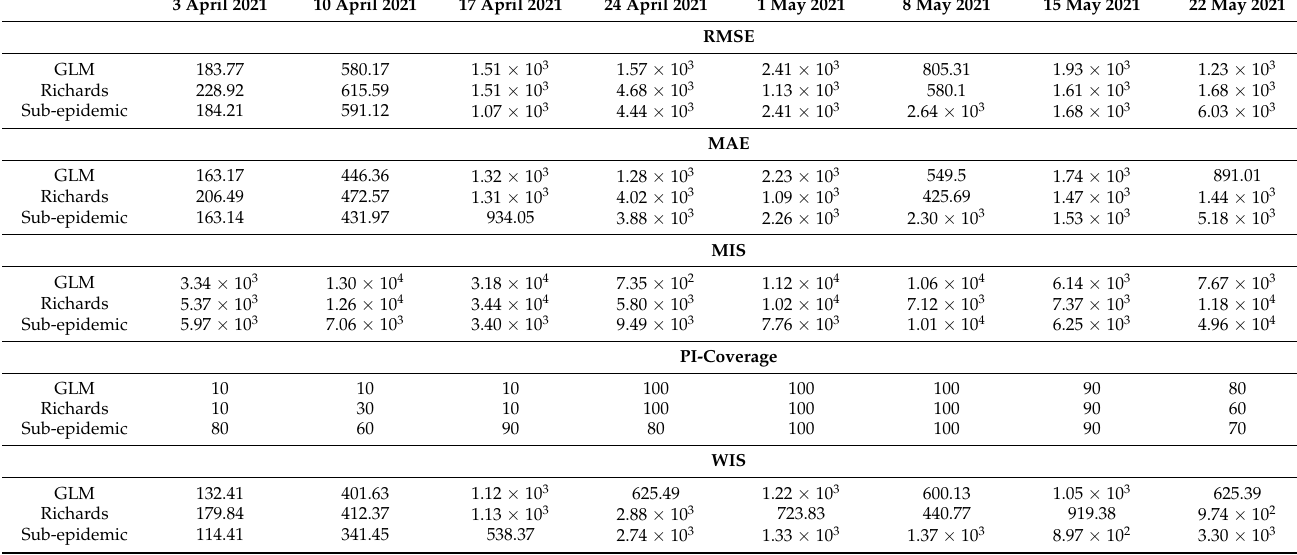
Table 2. Comparison of performance metric during 10-days ahead forecast.